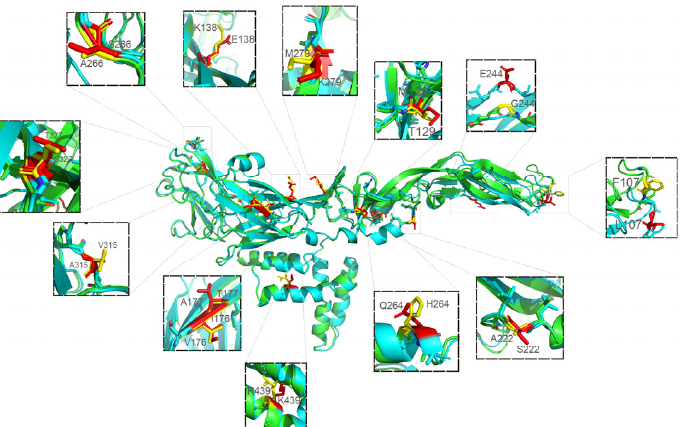
Figure 10. Display and comparison of modeled 3D structures between JEV CH/GD2014/2014 (CH/GD2018/2018) and CH/SA14-14-2 MSV/2018. The difference sites were at 107, 129, 138, 176, 177, 222, 244, 264, 279, 315, 327, 366 and 439 amino acids (green is the modeled 3D structures of vaccine strain; blue is the modeled 3D structures of CH/GD2014/2014 (CH/GD2018/2018); the different amino acids are distinguished by yellow and red: yellow for CH/SA14-14-2 MSV/2018 and red for CH/GD2014/2014 (CH/GD2018/2018).).